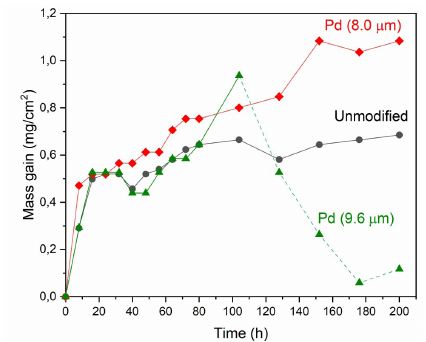
Figure 4. Mass gain of Pd-modified and unmodified aluminized coatings during isothermal oxidation at 1000 °C for 200 h.